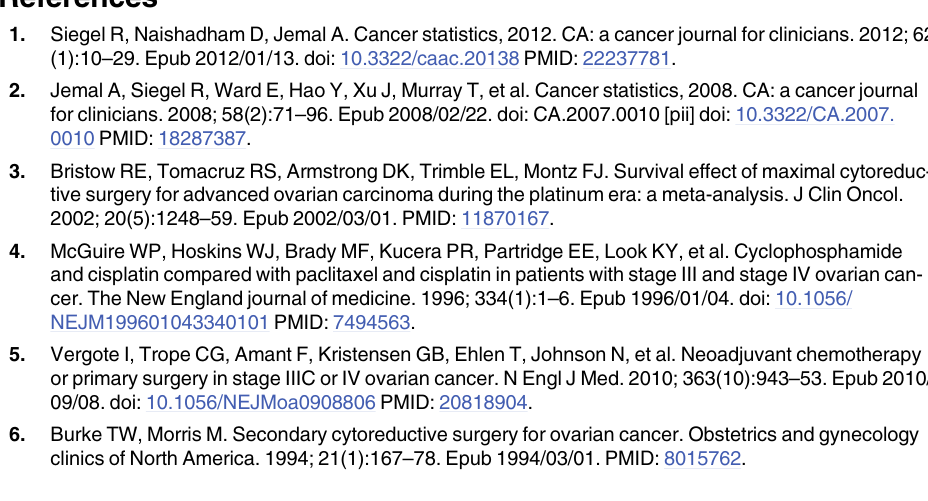
S1 Table. Comparative demographics in Early Relapse patients according to residual dis- ease status. S2 Table. Comparative demographics in Early Relapse patients with complete cytoreduc- tive surgery according to prognosis